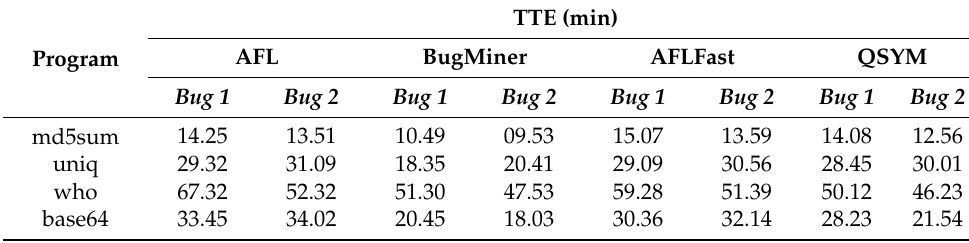
Table 3. Bug reproduction on LAVA-M